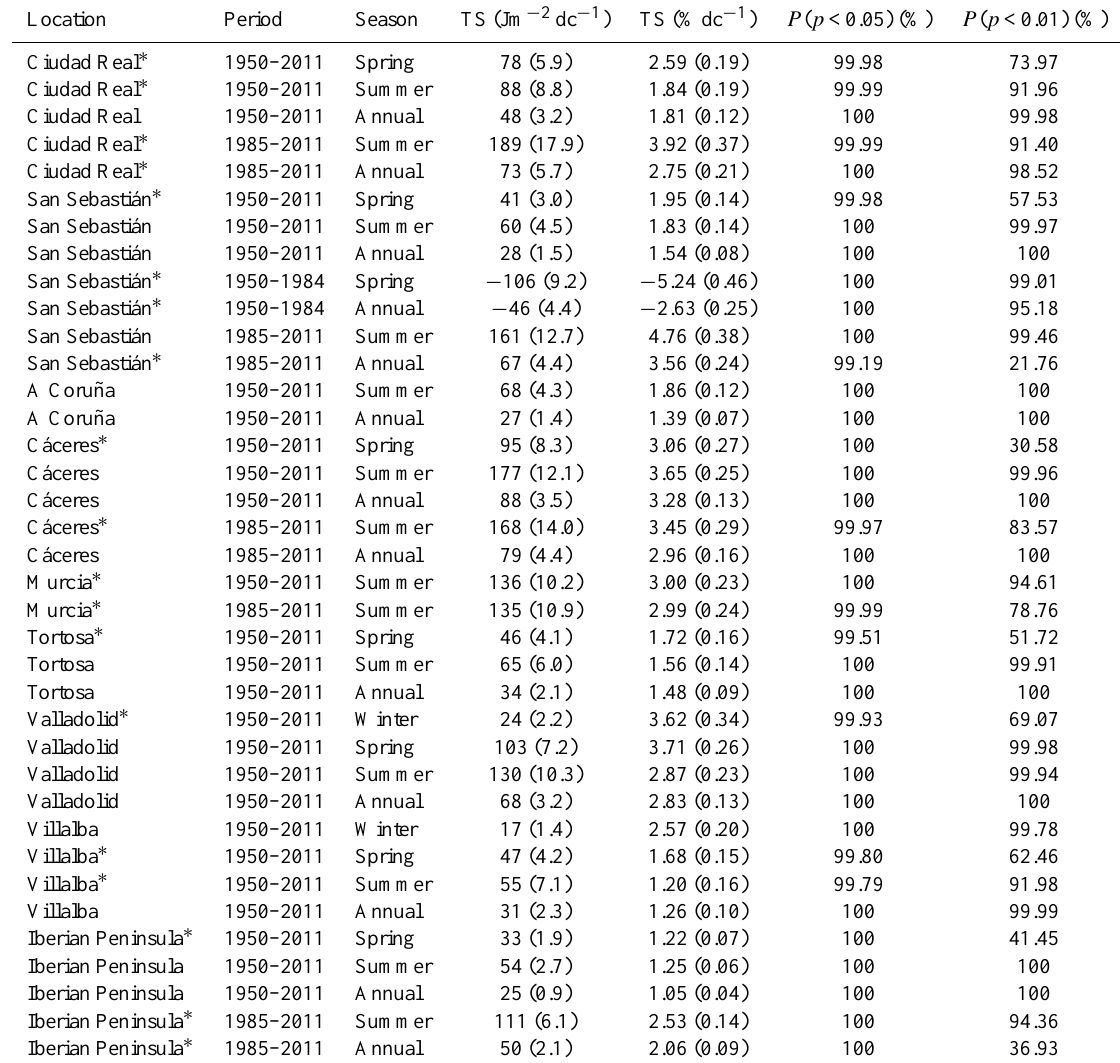
Table 4. Statistically significant UVER irradiation trends considered as the median of 10000 trends (standard deviation in parentheses), with a confidence of 99% (95% marked with an asterisk), and the P ( p < 0.05) and P ( p <0.01) values at various locations and seasons for